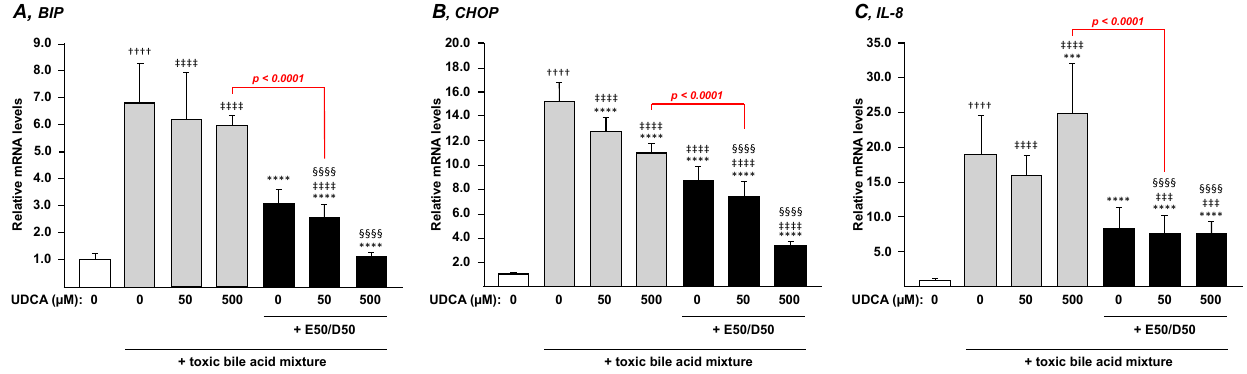
Figure 3. N-3 PUFAs strongly improve the ability of low and high UDCA doses to prevent ER stress and inflammation. HepG2 cells were exposed to vehicle (DMSO) or a toxic BA mixture (i.e., CA, CDCA, LCA and DCA, 100 µ M each) for 24 h in the absence or presence, of EPA/DHA (50/50 µ M), UDCA (50–500 µ M), or the EPA/DHA + UDCA combinations. Total RNA was extracted and analyzed for transcript levels of the ER-stress BIP ( A ) and CHOP ( B ) and inflammatory IL-8 ( C ) markers by qRT-PCR as detailed in the materials and methods section, and mRNA levels were expressed relatively to control cells set at 1. Data represent the mean of two independent experiments in which each treatment was performed in quadruplicate. Each data point therefore corresponds to the mean of 8 replicates ± SD. Statistical significances as determined by a one-way ANOVA followed by Tukey’s multiple comparison post-hoc were as follows: Untreated cells exposed to vehicle vs. untreated cells exposed to BA: †††† p < 0.0001; Vehicle cells vs. UDCA treated cells: ‡‡‡ p < 0.001;